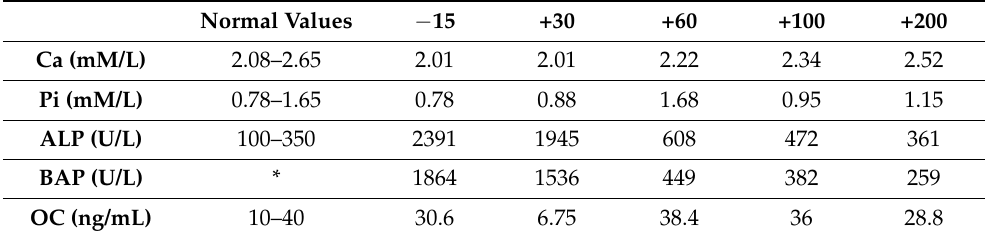
Table 1. Parameters of bone metabolism throughout the transplantation.